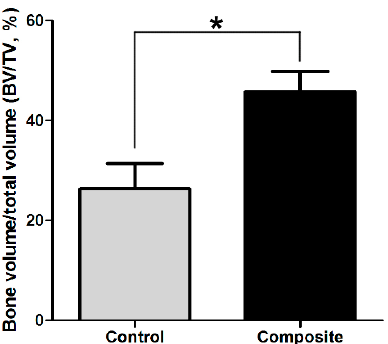
Figure 3. Comparisons of bone volume to total volume ( BV / TV , %). The three-dimensional BV / TV values calculated based on the micro CT images differed significantly between the newly formed bone in the composite and control groups (* p < 0.05).